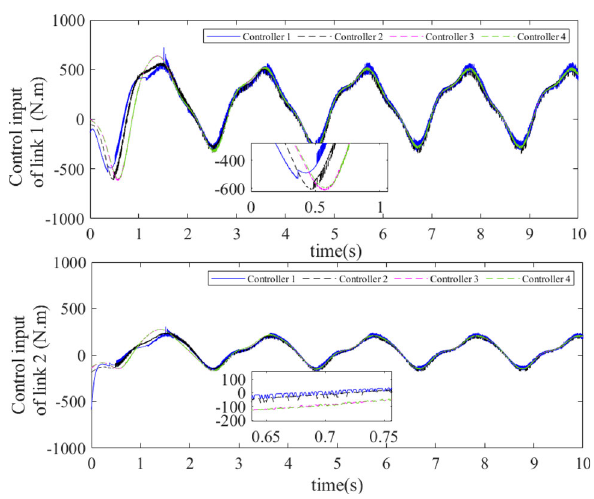
Fig. 8 Error convergence curve